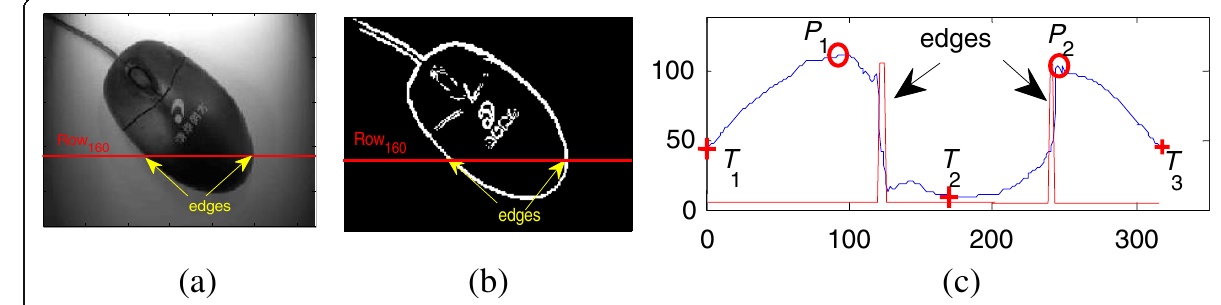
Fig. 4 a The mouse image. b The edge information obtained by the Sobel operator. c The gray wave curve (the blue curve) and the edge information (the red curve) of the 160th row for the mouse